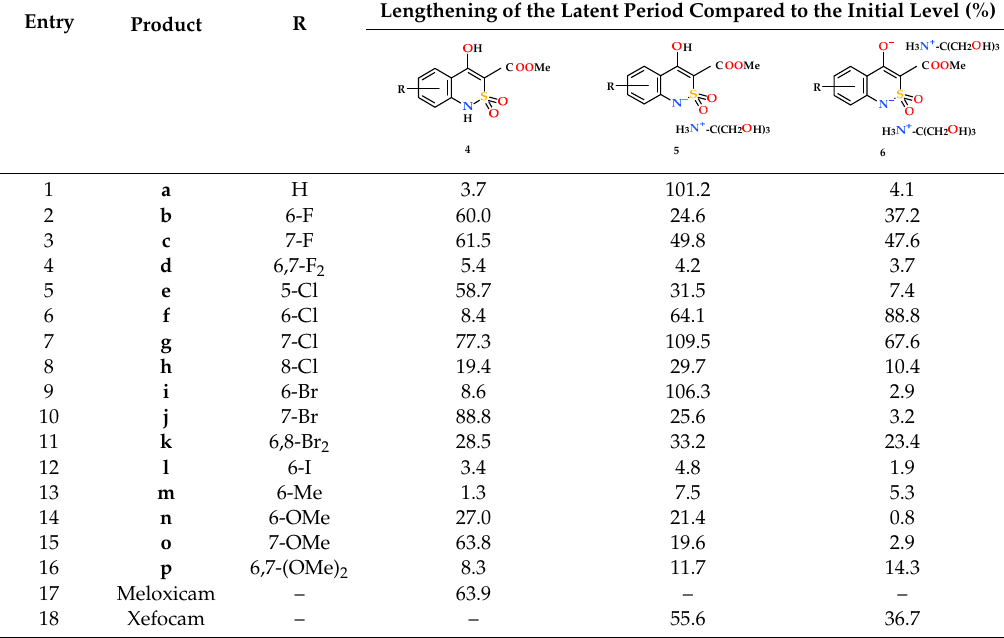
Table 2. The analgesic activity of esters 4 , their mono-( 5 ) and di-( 6 ) ammonium salts with tris(hydroxymethyl)aminomethane on the “tail-flick” model in rats. Entry Product